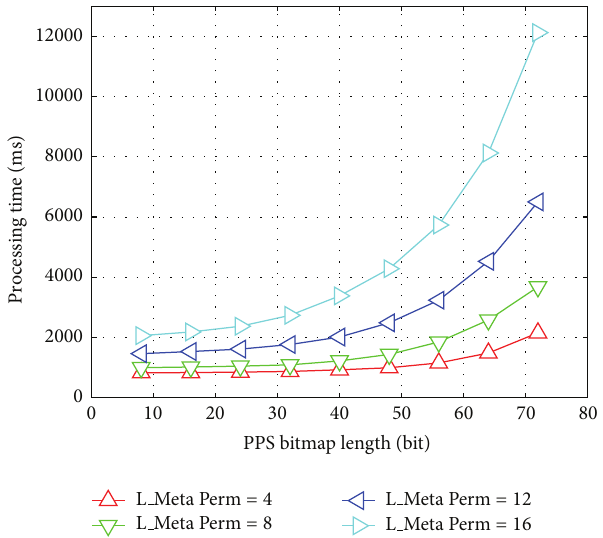
Figure 4: Processing time with respect to PPS bitmap length.